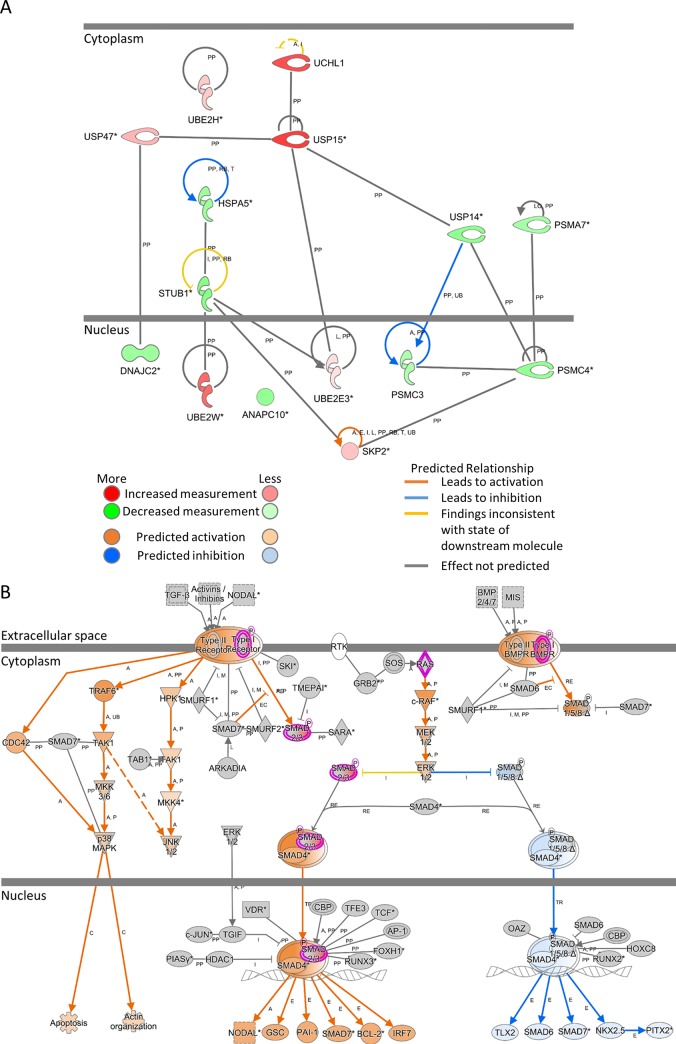
IPA cellular view of: A) 15 affected molecules in the significant Protein Ubiquitination pathway. B) Canonical pathway TGF-β Signaling pathway, coloring indicating measured and predicated states.